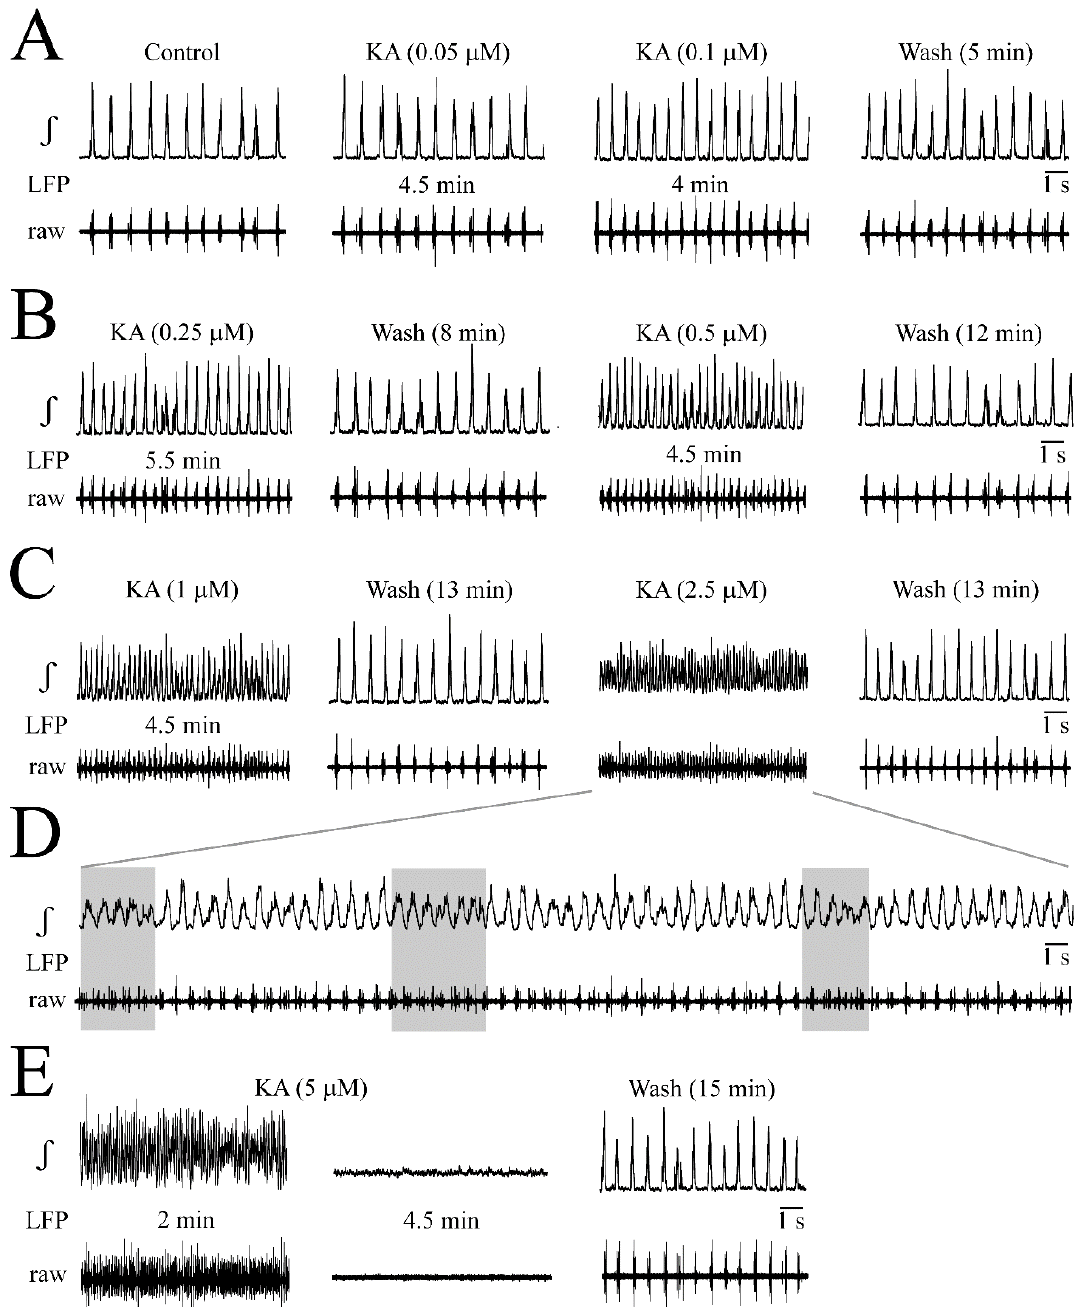
Figure 3. LFP oscillations caused by the iGluR agonist kainate (KA). ( A , B ) With no effect of bath- application for 5 min of 0.05 µM KA, both 0.1 and 0.25 µM accelerated LFP events which merged at 0.5 µM into faster sinusoidally-shaped oscillations showing every 2–3 s amplitude fluctuations of